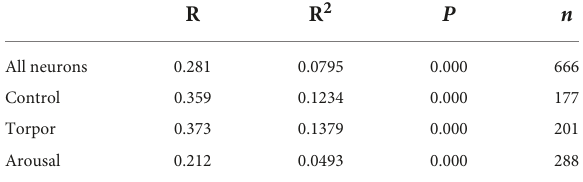
TABLE 1 R, R 2 , and p -values corresponding to the correlation analysis (SPSS software, v.22) between the intensity of C-Fos and